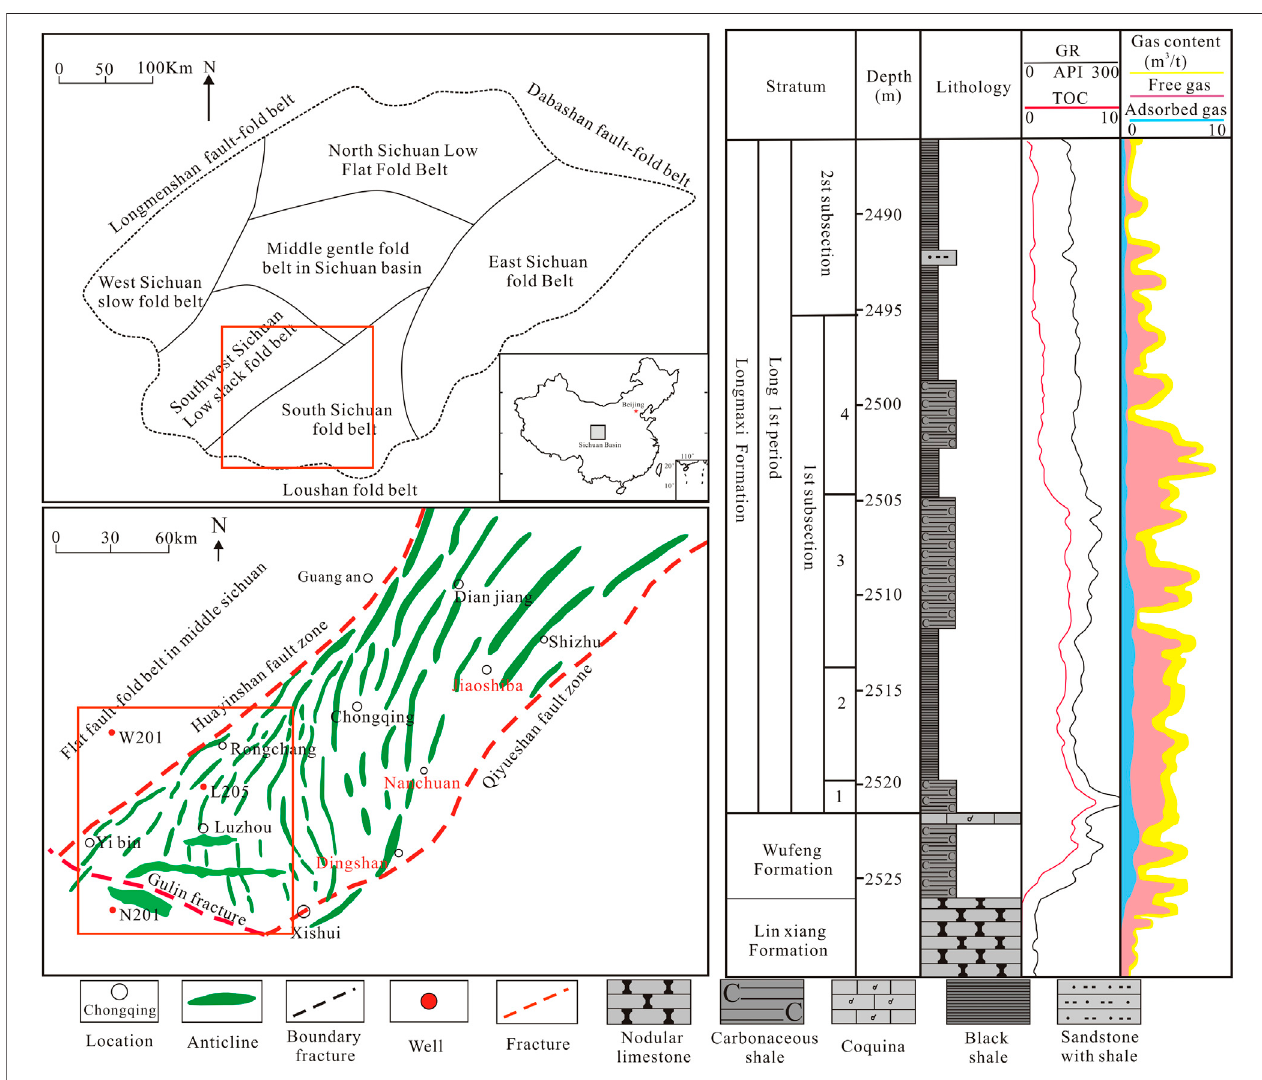
FIGURE 1 | Comprehensive histogram of the regional geological setting and stratigraphy in southern Sichuan.